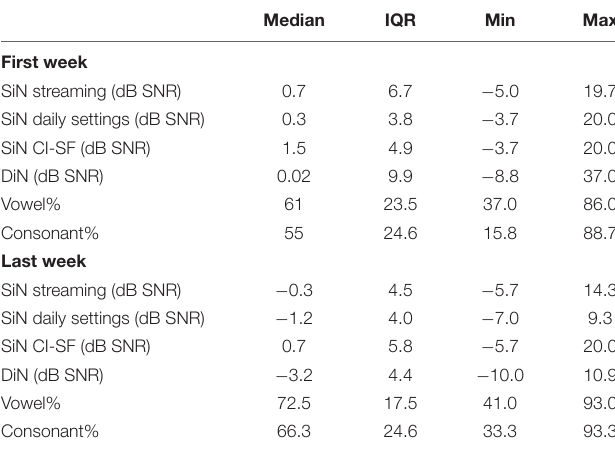
TABLE 1 | Median SRT in noise and IQR, min and max for SiN in streaming mode, daily settings, and sound-field, only 1 CI (CI-SF) for the first and last session separately ( n =